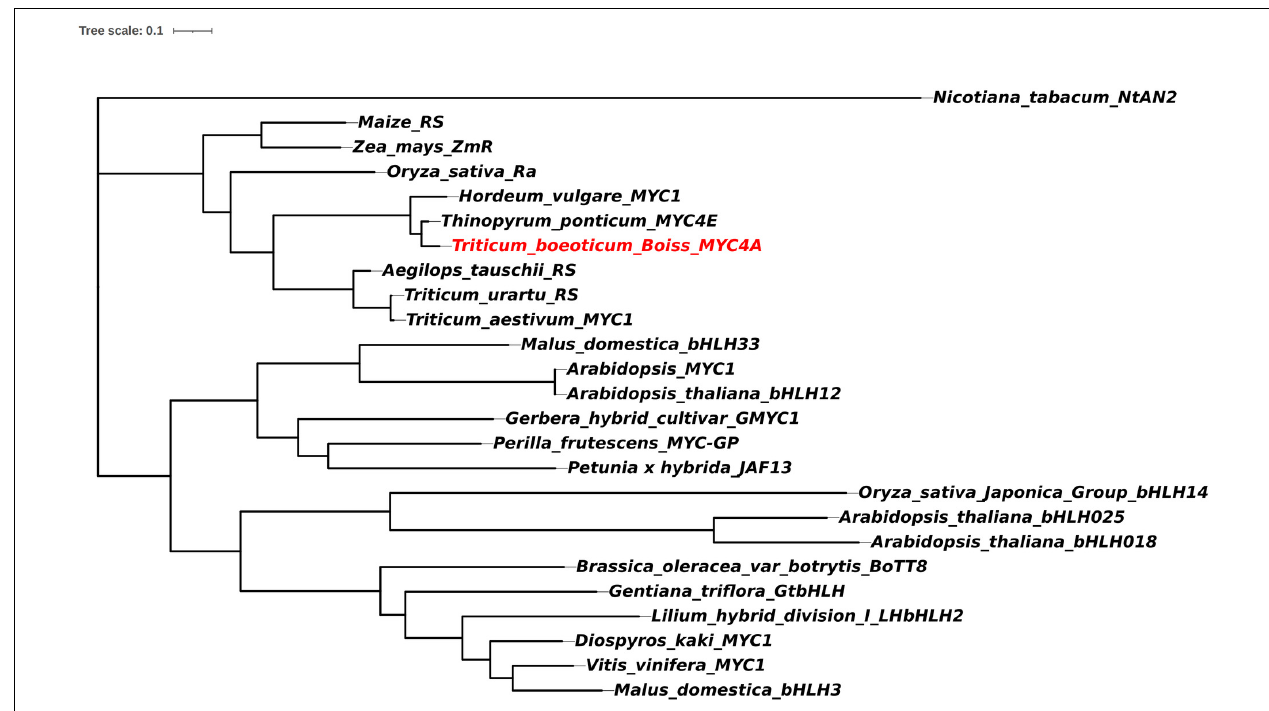
FIGURE 2 | Phylogenetic tree of bHLH proteins regulating anthocyanin biosynthesis. The accession numbers of these proteins (or translated products) in the GenBank database are as follows: Nicotiana tabacum /NtAN2:ACO52472.1; Oryza /OsbHLH14:XP_015649359.1; Arabidopsis thaliana /bHLH025:Q9T072.2; Arabidopsis thaliana /bHLH018:Q1PF17.1; Brassica oleracea var.botrytis /BoTT8: ADP76654.1; Gentiana triflora/GTbHLH1:BAH03387.1; Lilium hybrid division I/ LHbHLH2:BAE20058.1; Diospyros kaki /MYC1:AEC03343.1; Vitis vinifera/ MYC1: ACC68685.1; Malus domestica /MdbHLH3:ADL36597.1; Malus domestica /MdbHLH33:AAC49219.1; Arabidopsis thaliana /MYC1:NP_191957; Arabidopsis thaliana /bHLH12:AAL55719.1; Gerbera hybrid cultivar /GMYC1: CAA07615.1; Perilla frutescens /MYC-GP:BAA75514.1; Petunia x hybrida /JAF13: AAC39455.1; Oryza /Ra:AAC49219; Maize /RS:NP_001106073; Zea mays /ZmR: NP_001105339.2; Hordeum_vulgare /MYC2:MF679157.1; Thinopyrum ponticum/ MYC4E:KX914905.1; Aegilops tauschii /R-S:KD566857.1; Triticum urartu /RS: KD032825.1; and Triticum aestivum /MYC1:KY499900.1.